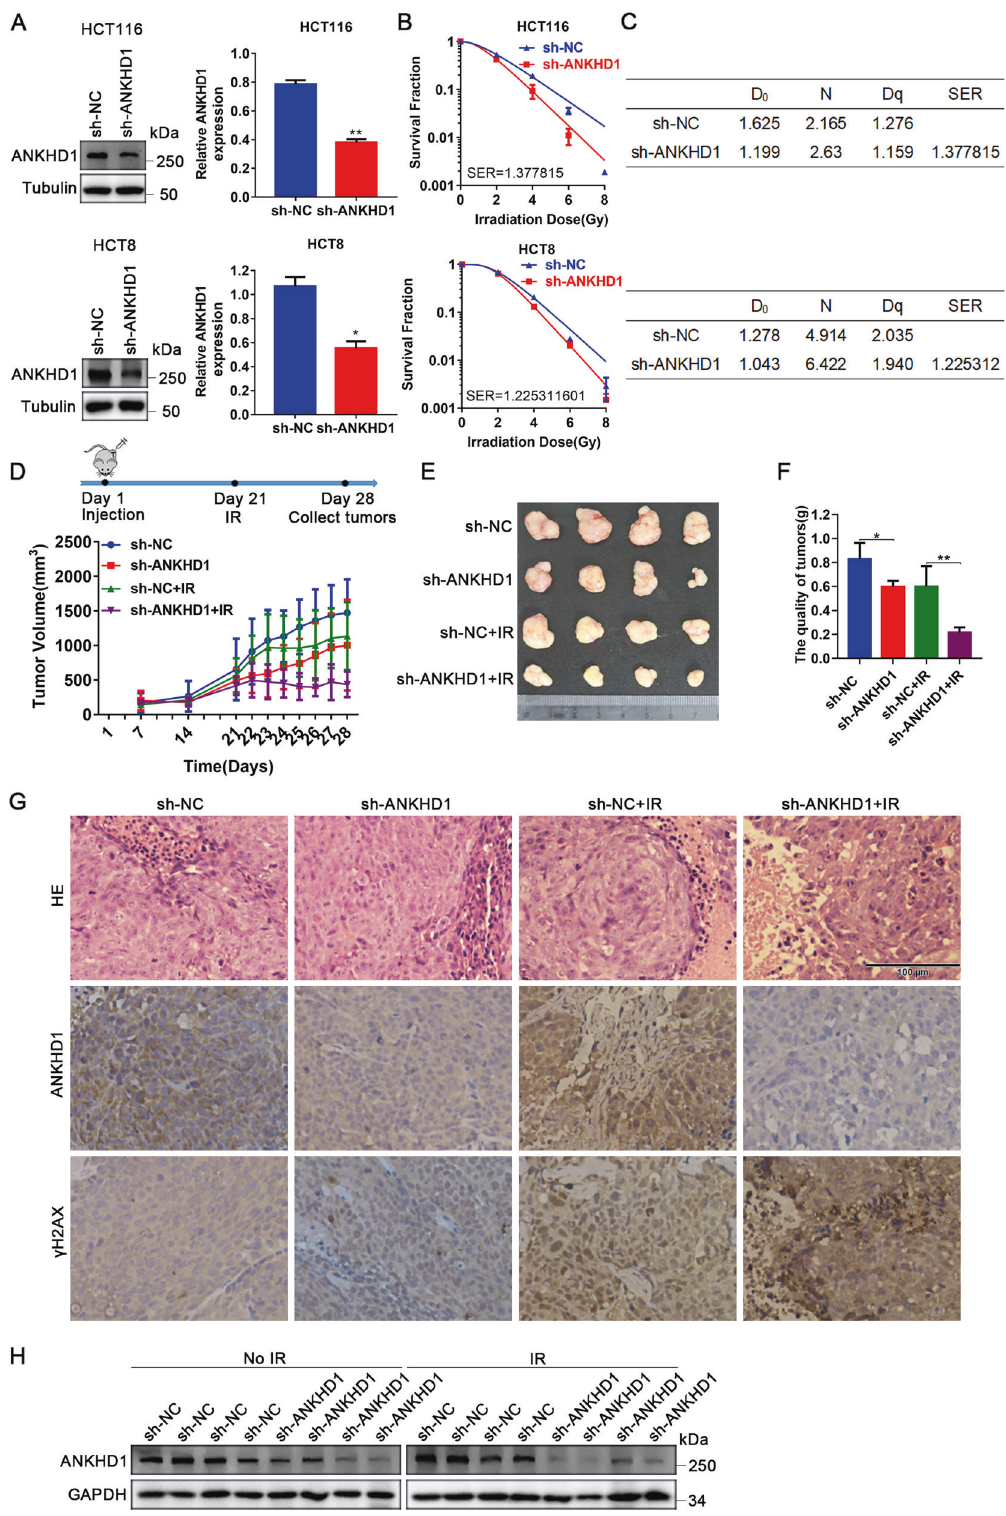
Fig. 1 ANKHD1 knockdown enhanced the radiosensitivity of CRC both in vitro and in vivo. A ANKHD1 expression levels were tested by Western blot in HCT116 and HCT8 cells infected with lentivirus-targeting ANKHD1, the silencing ef fi ciency was analyzed using Image J (* P < 0.05, ** P < 0.01). B ANKHD1 silencing increased the radiosensitivity of HCT116 and HCT8 colorectal cancer cells (SER = 1.378 in HCT116, SER = 1.225 in HCT8). C The D 0 , N, Dq, and SER values of ANKHD1-silenced cells, the SER value was simulated using the multi-target single-hit model. D , E Tumor- growth curves and images of all tumors of each group ( n = 5 and 4 tumors were observed). F The quality of each group tumors (* P <0.05, ** P < 0.01). G H&E staining of tumor section of all groups in this study, IHC was performed to test the expression of ANKHD1 and γ H2AX in the tumor section of all groups in this study. H The expression of ANKHD1 in subcutaneous tumor tissues was detected by Western blot.